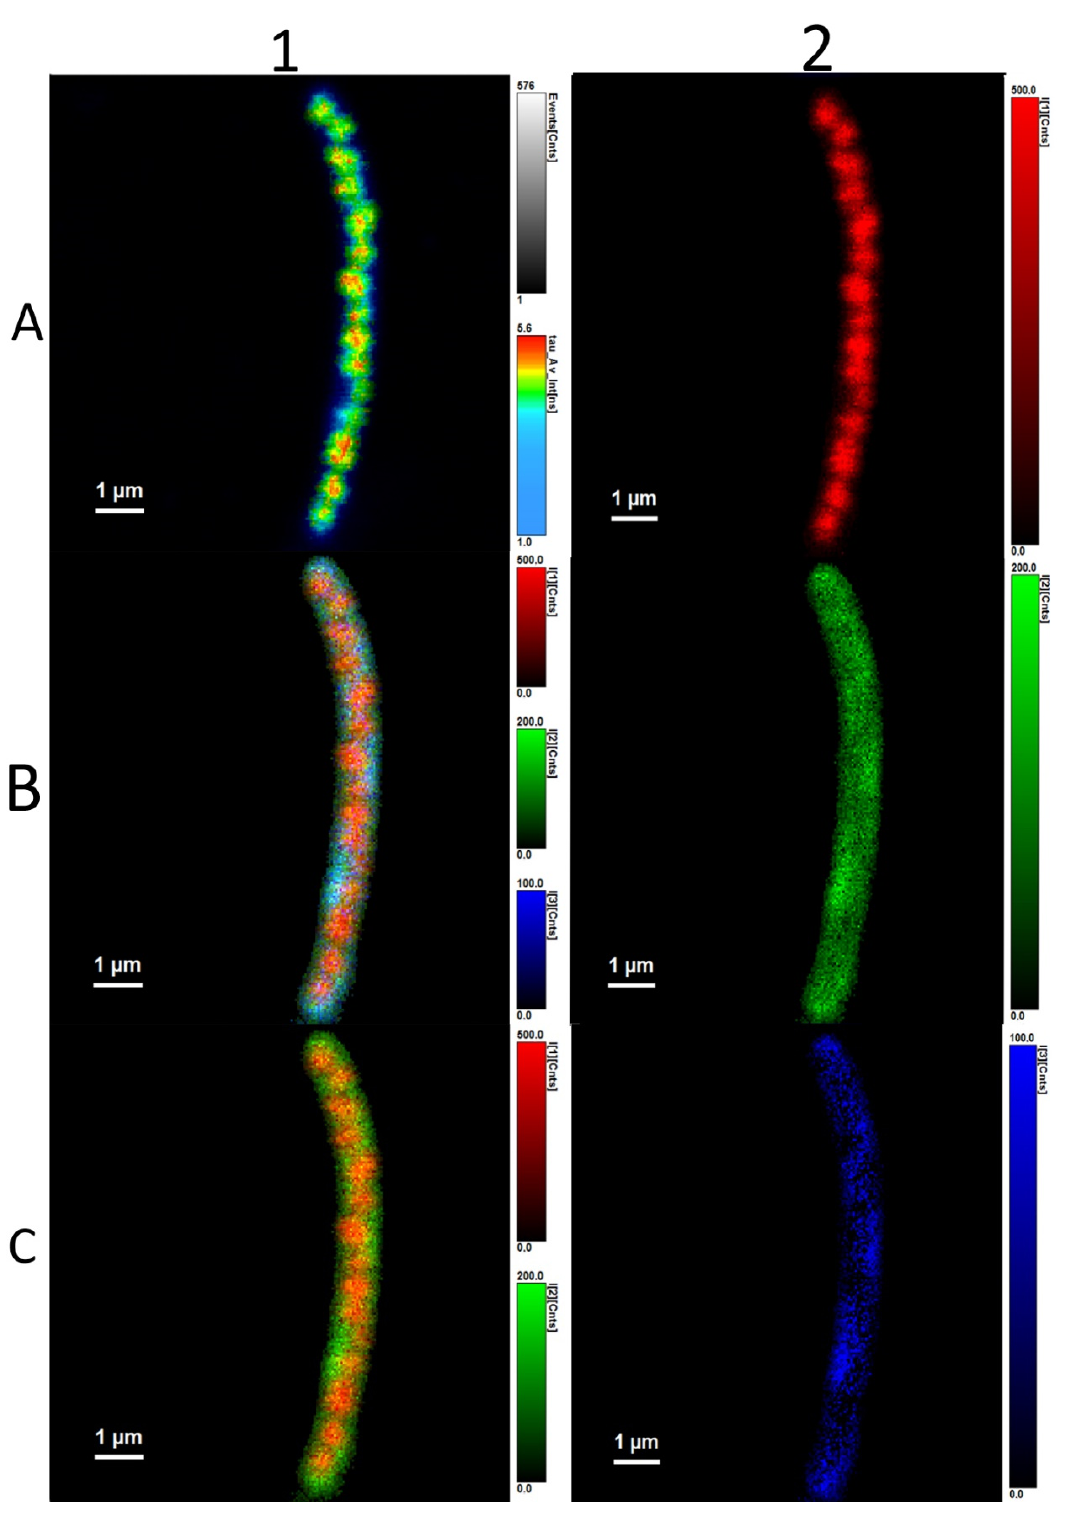
Figure 7. Cupriavidus necator H16. Autofluorescence ( 1A ), all three different lifetimes of fluorescence of flavins observed are combined in one picture ( 1B ), two average fluorescence lifetimes of flavins found ( 1C ). The three different fluorescence lifetimes are imagined here separately: 4.800 ± 0.015 ns ( 2A ), 1.220 ± 0.044 ns ( 2B ), and 0.00532 ± 0.00144 ns ( 2C ).